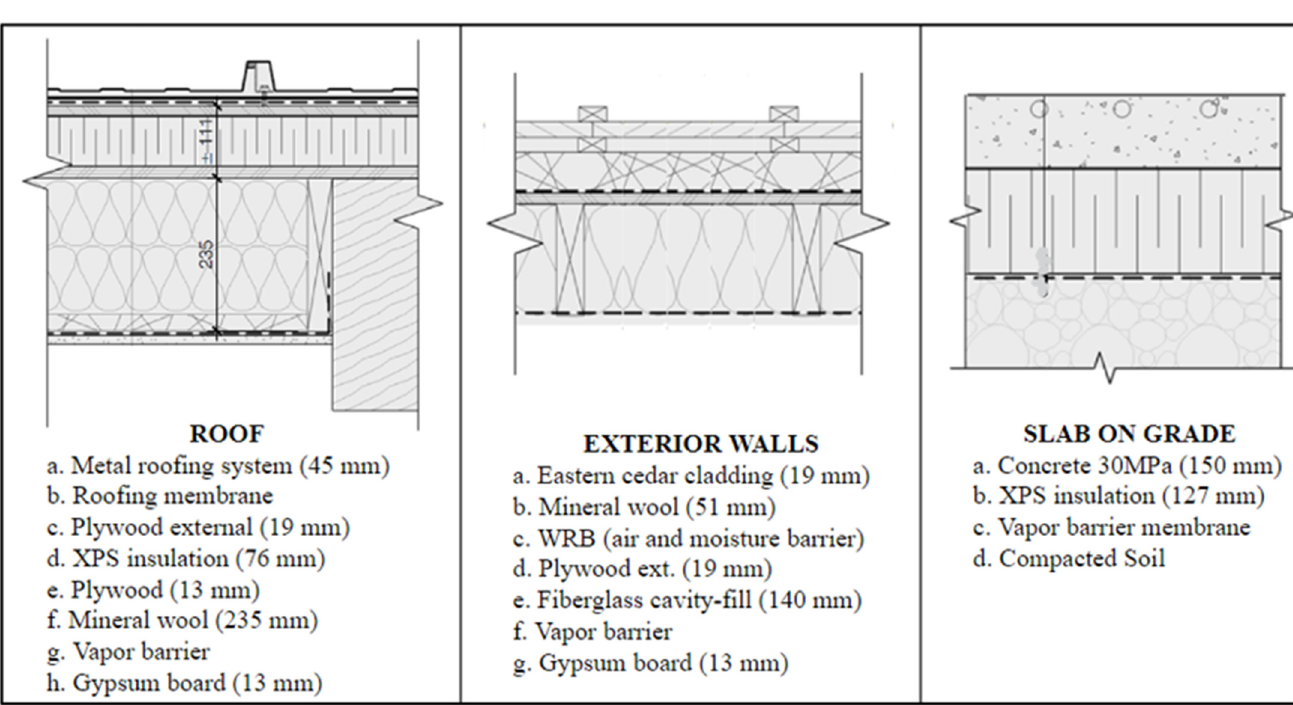
Figure 4. Typical sections of the envelope assemblies.